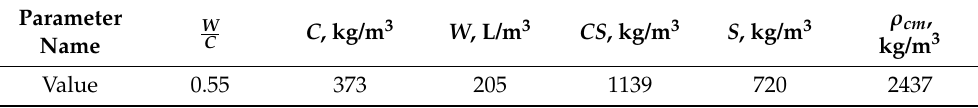
Table 7. Parameters of the composition of the concrete mixture.